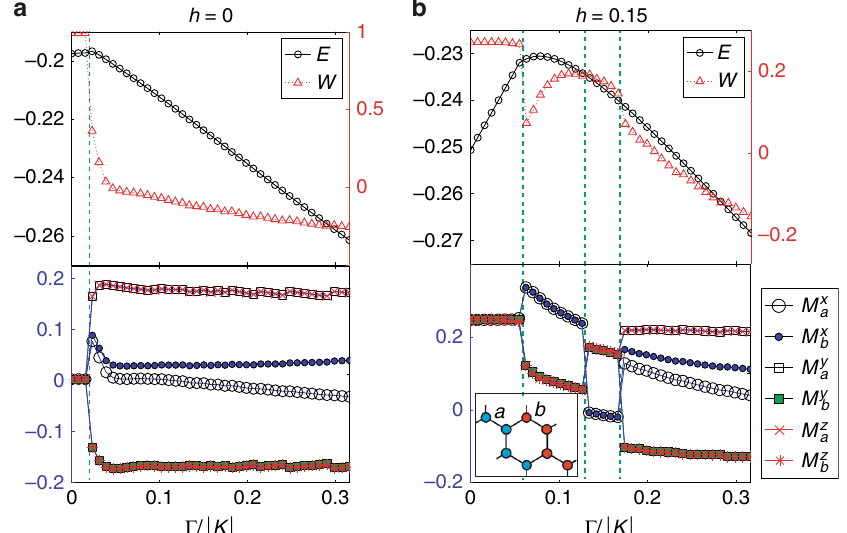
Fig. 2 Distinguishing phases. Plots of variational energy E , fl ux W (upper), and components of magnetization M γ a ; b (lower) at a h ¼ 0 and b h ¼ 0 : 15 as a function of Γ = j K j with Γ 0 ¼ (cid:3) 0 : 03. The green dotted lines specify the phase boundaries. The information on numerical parameters is given in the “ Methods ” section.